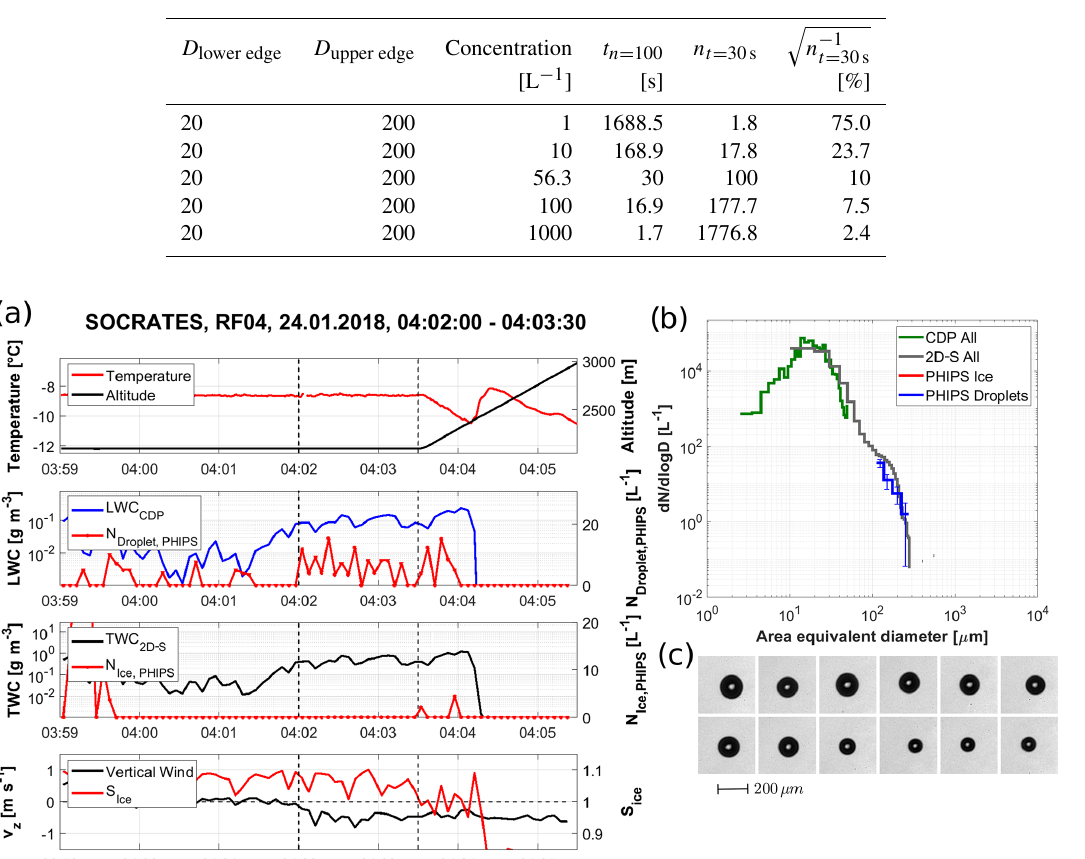
Table 2. Averaging time that is needed until n = 100 particles are sampled as well as the total number of particles sampled during an averaging time of 30s, calculated for the size bin of 20–200µm and exemplary particle concentrations.